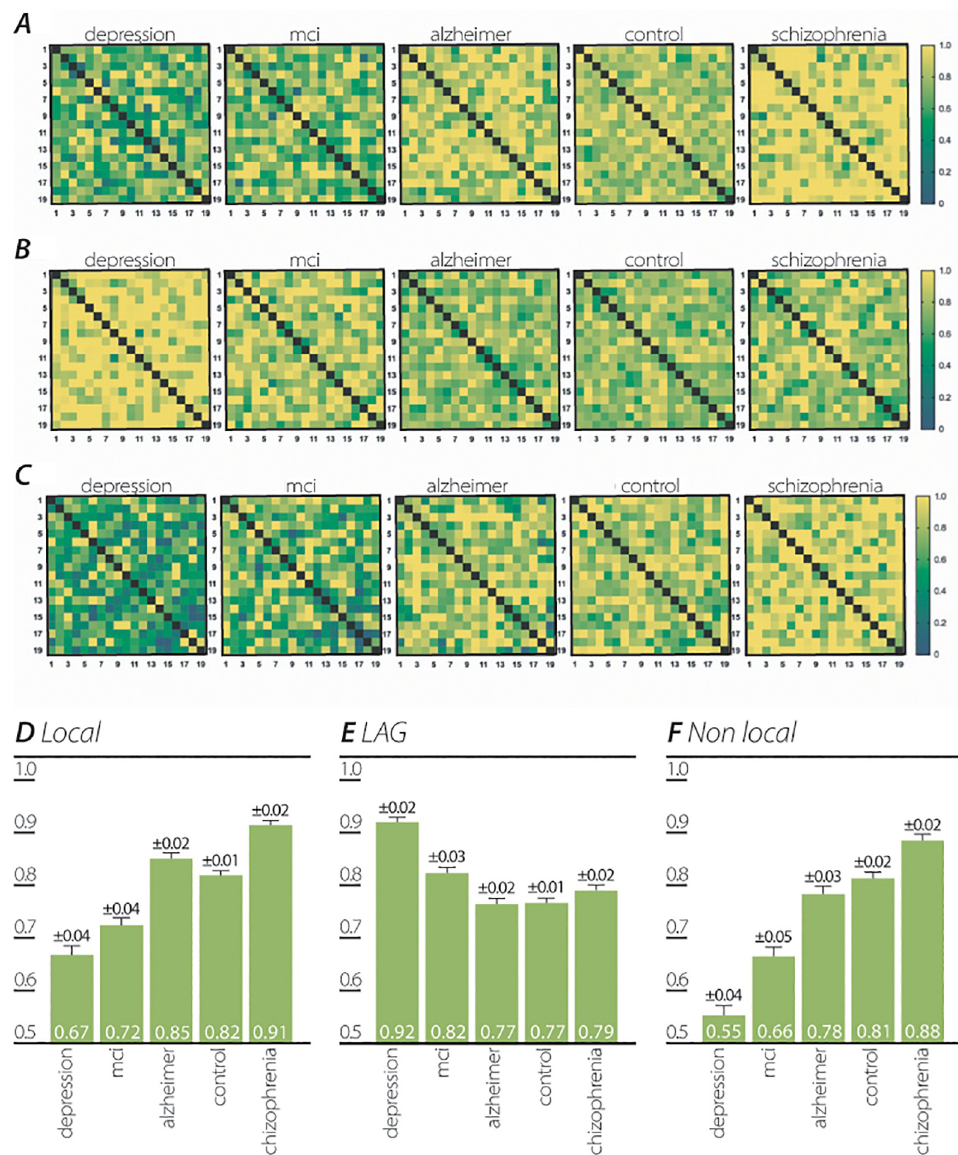
Fig 2. Cross correlation of time series QP between EEG electrodes. (A)Heatmaps of maximum correlation coefficients between each pair of electrodes QP (QP elec,t, participant ) time series. Each correlation coefficient was normalized to the maximum correlation coefficient of all patient groups. (B) Heatmaps of temporal difference (lag) of maximum correlation coefficient between each pair of electrodes QP (QP elec,t,participant ) time series. Each temporal difference was normalized to the maximum temporal difference of all patient groups. (C) Heatmaps of instantaneous correlation coefficients (lag = 0) between each pair of electrodes QP (QP elec,t,participant ) time series. Each instantaneous correlation coefficient was normalized to the maximum instantaneous correlation coefficient of all patient groups. (D) Mean maximum correlation coefficients. (E) Mean of temporal difference (lag) of maximum correlation coefficient. (F) Mean of instantaneous correlation coefficients (lag = 0). Error bars indicate standard error of mean (SEM).